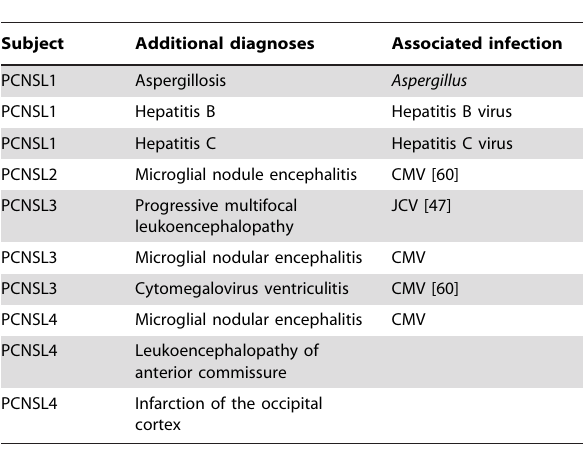
Table 1. Clinical diagnoses besides PCNSL for four PCNSL